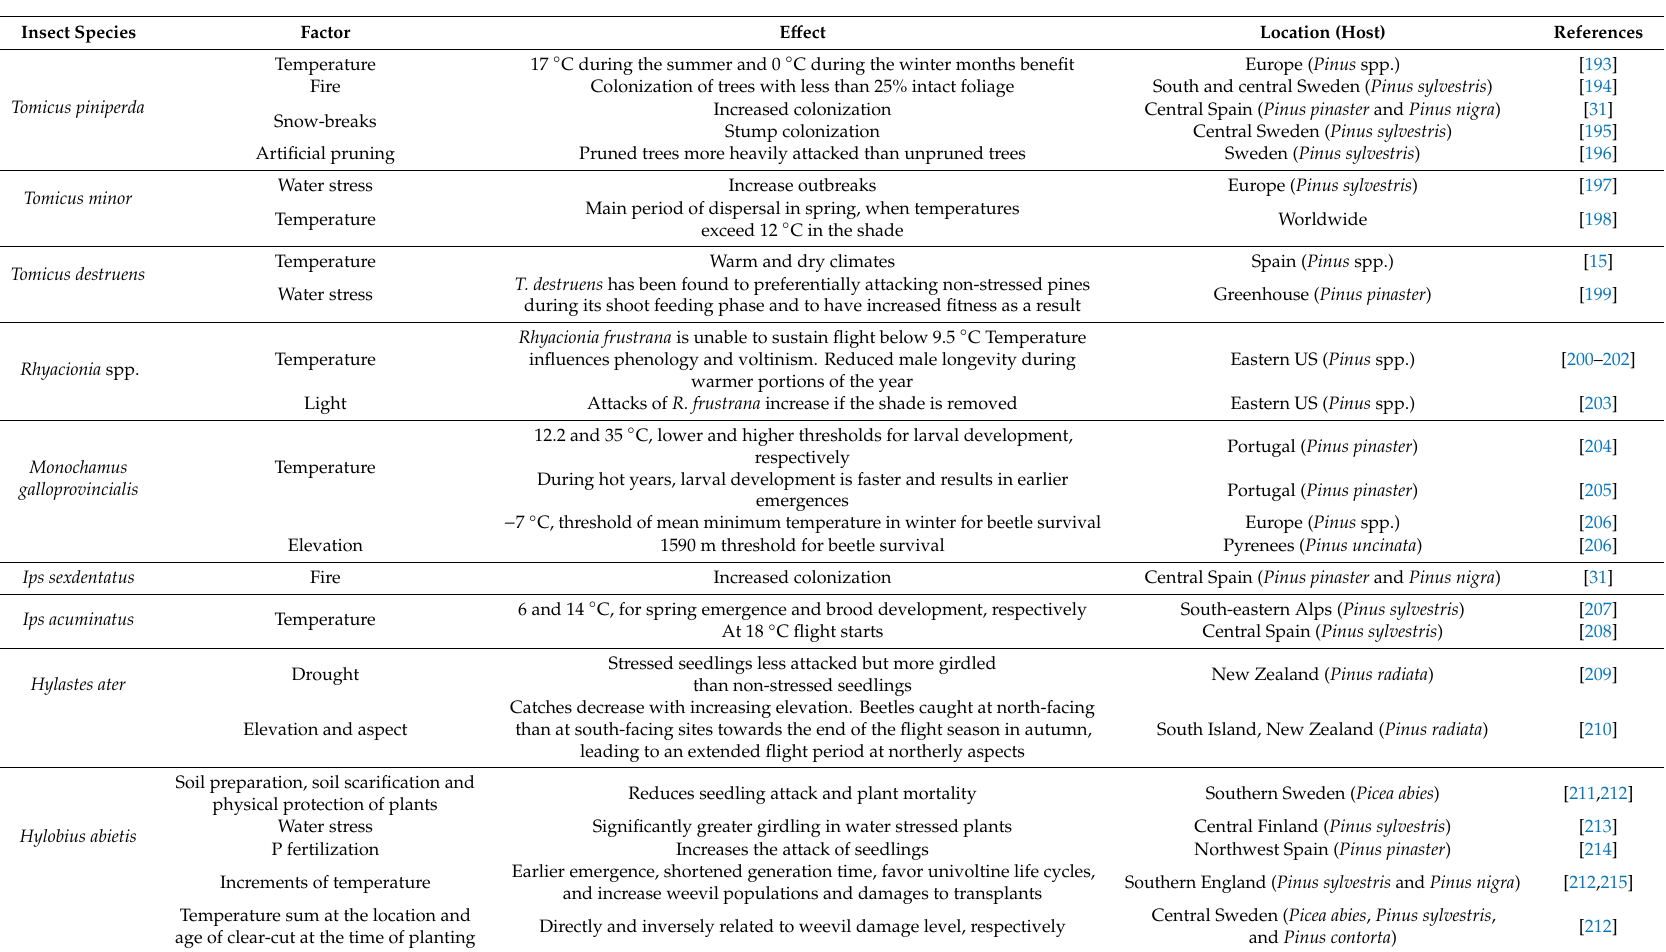
Table 1. E ff ect of environmental factors and silvicultural measures on insects associated to the pine pitch canker (PPC)